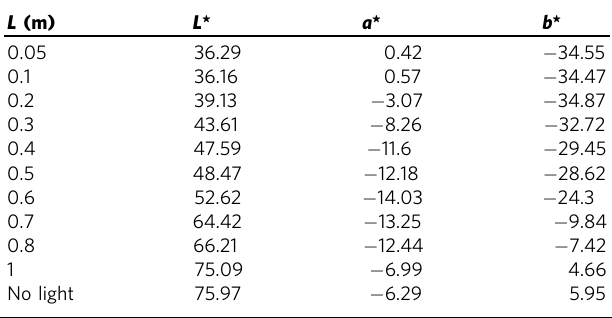
Table 2 L *, a *, and b * changes with different light density of DPV-based PSC-powered ECD.